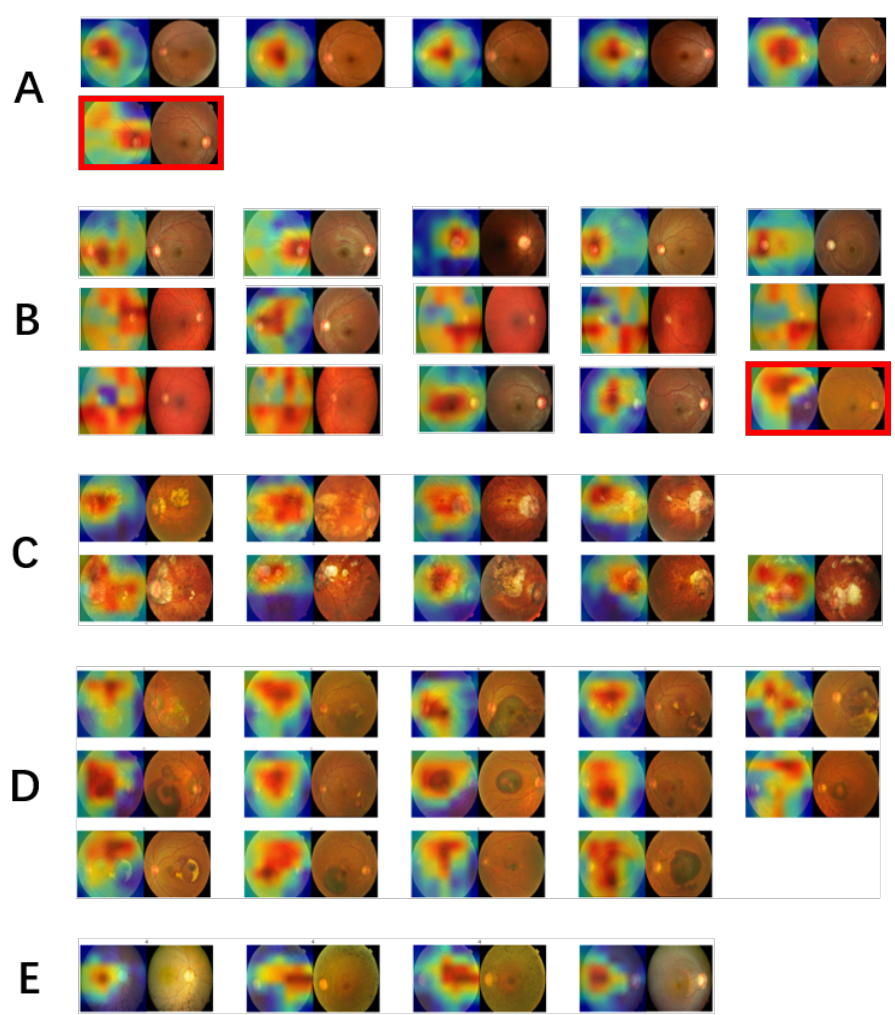
Figure 5. The original images in the test dataset and their corresponding heatmaps generated by our algorithm showing the weight distribution contributing to the classification of different labels. Each of the two misclassified images is marked with a red frame around it. The true class labels are: ( A ) for Normal, ( B ) for Glaucoma, ( C ) for Pathological Myopia, ( D ) for Maculopathy, and ( E ) for Retinitis Pigmentosa.